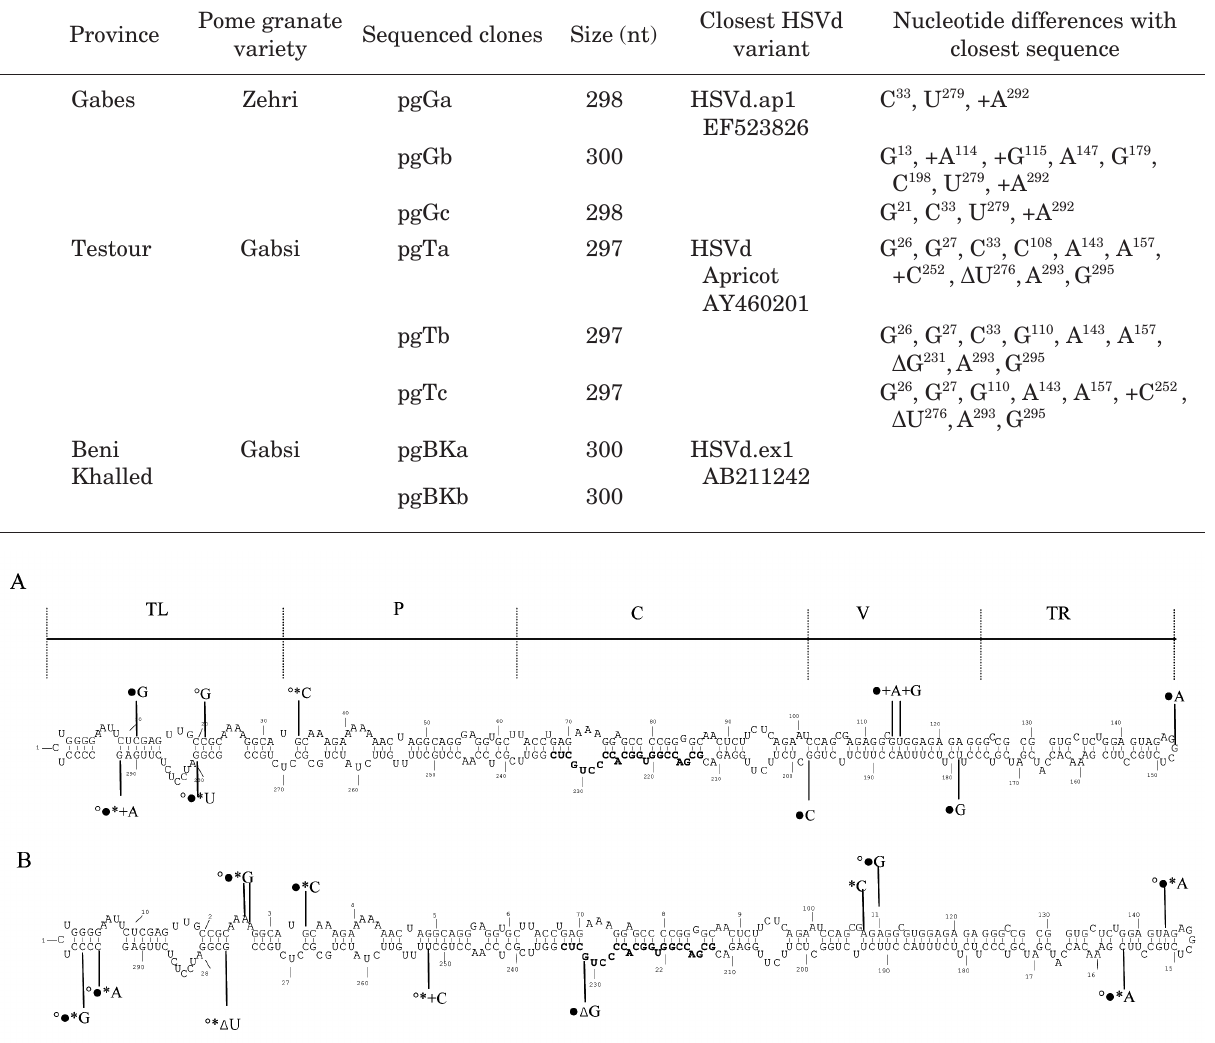
Figure 2. Most stable predicted secondary structure of Hop stunt viroid (HSVd) using the mfold program showing nucleotide changes within the Tunisian pomegranate HSVd variants, compared to the reference isolate HSVdh1 (Ohno et al ., 1983). (A). HSVd-pgG variants corresponding to pomegranate isolates from the Gabes region; (B), HSVd-pgT variants corresponding to pomegranate isolates from the Testour region. The secondary structure is shown with the boundaries of the terminal left (TL), pathogenicity (P), central conserved (C), variable (V) and terminal right (TR) domains. * Variant a, ● Variant b, ° Variant c. Nucleotide substitutions are indicated: + insertion, Δ